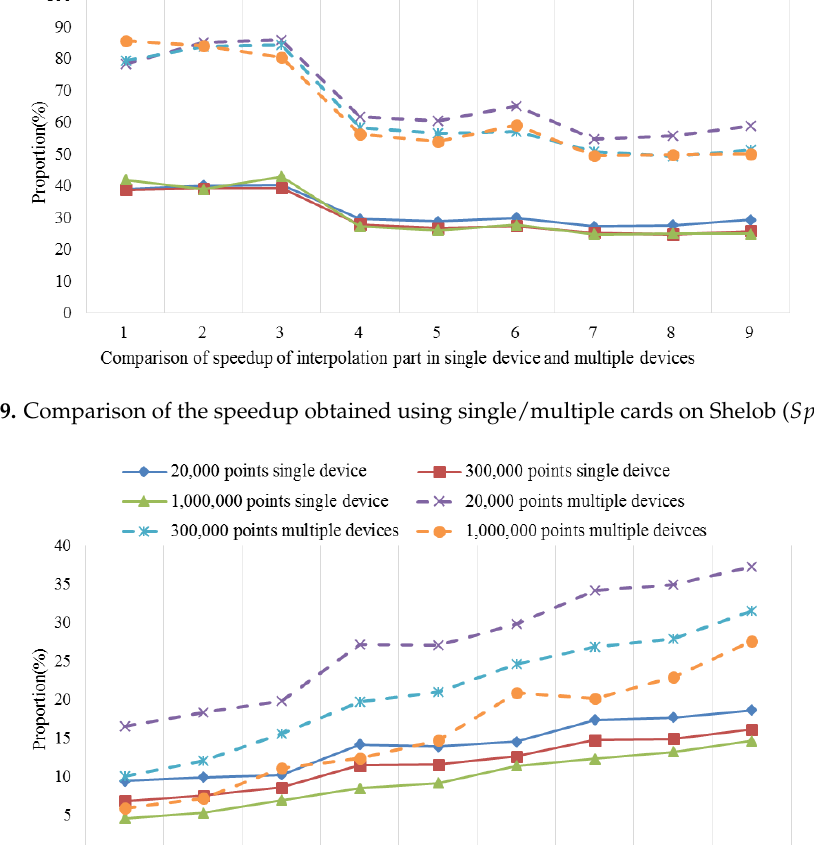
Figure 10. Comparison of the speedup obtained using single/multiple cards on Shelob ( 𝑆𝑝𝑒𝑒𝑑𝑢𝑝